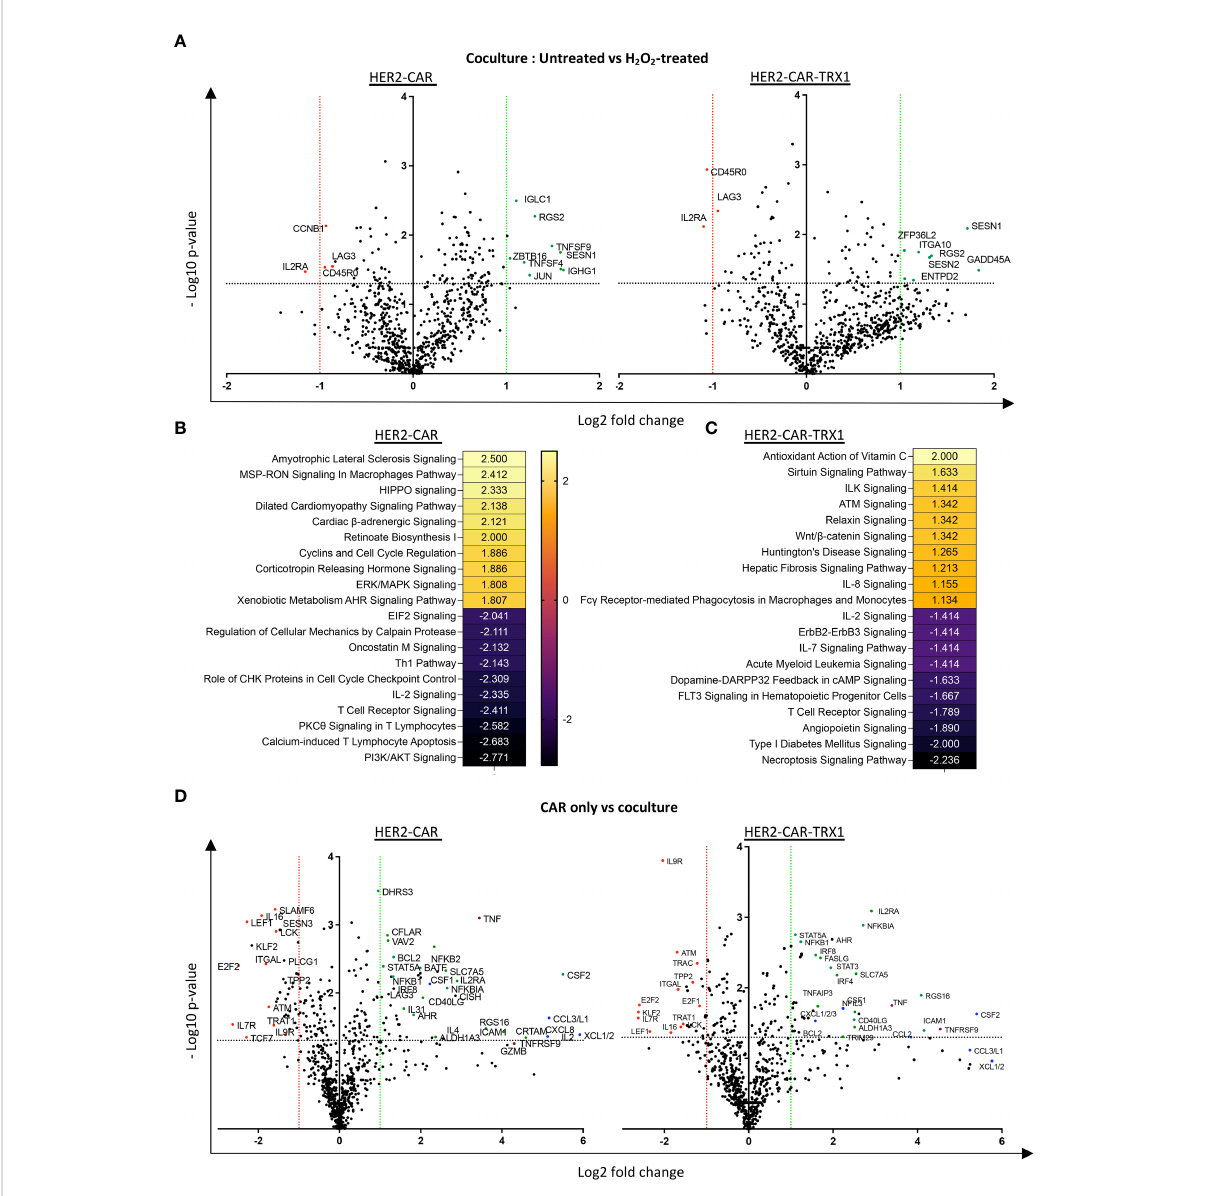
FIGURE 7 A pro-oxidative micromilieu alters CAR T cell gene expression. Ctrl-, HER2-, and TRX1-enhanced CAR T cells were untreated or treated with H 2 O 2 for 1 h. Cells were then cultured alone or cocultured with SKBR3 cells at a 5:1 CAR T cell: SKBR3 ratio. Cells were harvested 5 h later, and total RNA isolated and processed by nCounter mRNA analysis. (A) Volcano plot showing Log 2 transformed mRNA expression in cocultured HER2-CAR T cells (left) and HER2-CAR-TRX1 T cells under control vs pro-oxidative conditions. (B, C) Ingenuity pathway analysis (IPA) of differentially regulated genes in untreated vs H 2 O 2 -treated (B) HER2-CAR and (C) HER2-CAR-TRX1 T cells under coculture conditions. (D) Expression differences between CAR T cell only vs CAR T cell/SKBR3 cocultures of HER2-CAR T cells (left) and HER2-CAR-TRX1 T cells (right) under control